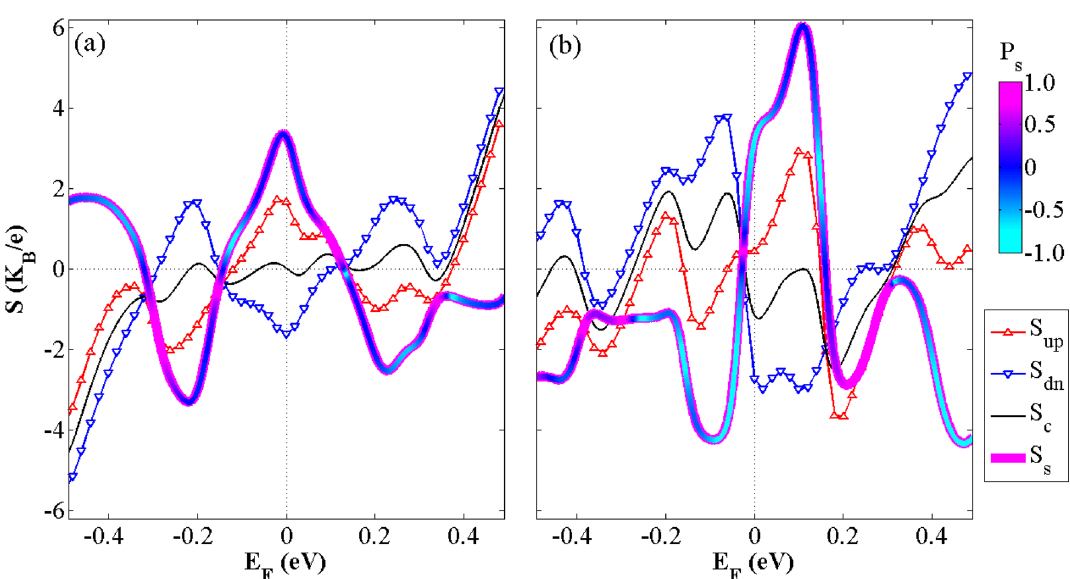
Figure 9. The variations of the spin-up ( S up ), spin-down ( S dn ), spin ( S s ) and charge ( S c ) Seebeck coefficients versus the Fermi energy and at room temperature for ( a ) the SSE and ( b ) the SFE cases. The S S color changes in accordance with the Seebeck polarization